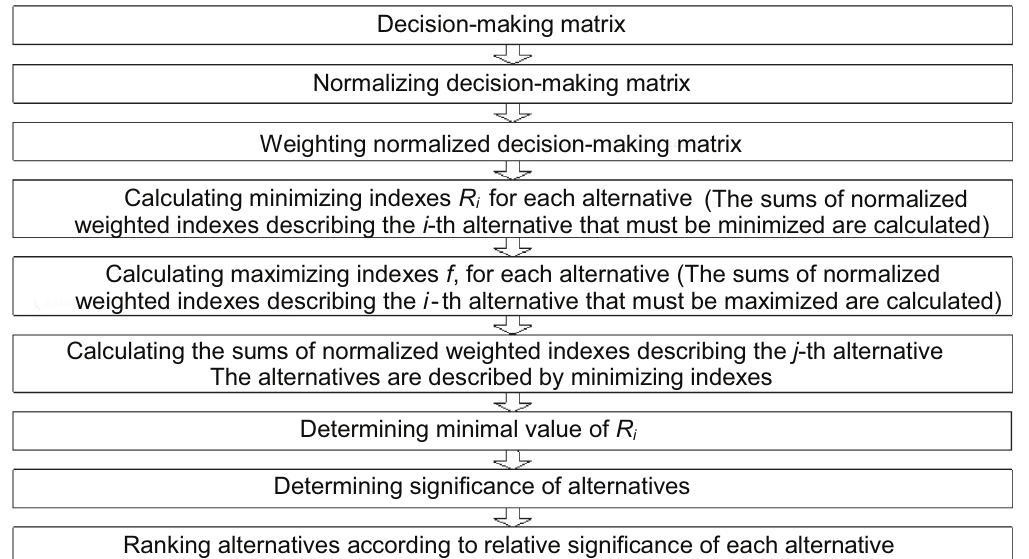
figure 2. ranking of alternatives by applying CoPras method